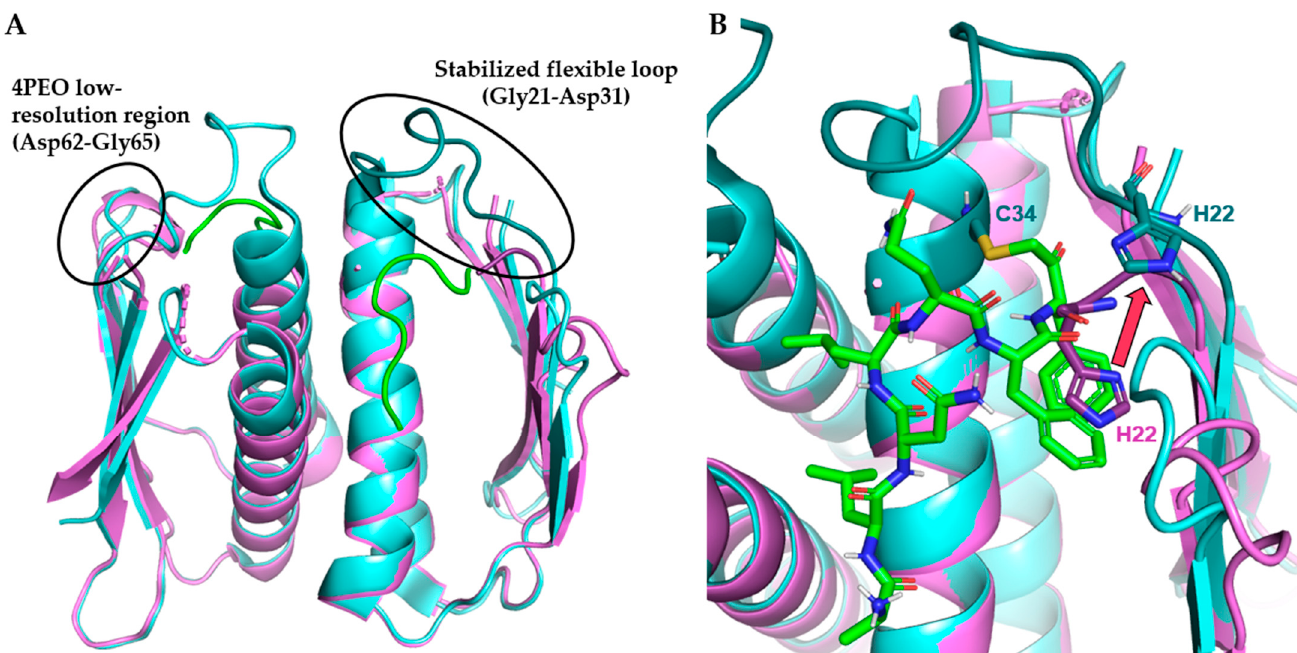
Figure 5. Surface representation of published Sa Prp structures. ( A ). Unbound Sa Prp (4PEO, violet, 1.73 Å) overlaid with liganded Sa Prp (7KLD, cyan, 2.25 Å) bound to covalent to L27-like covalent inhibitor (KLNLQFF-CMK, green). ( B ). Sa Prp binding site showing movement of catalytic His22 upon binding (red arrow). Flexible loop and catalytic residues in darker shades. All images produced with PyMOL Molecular Graphics System, Version 2.0 Schrödinger, LLC.